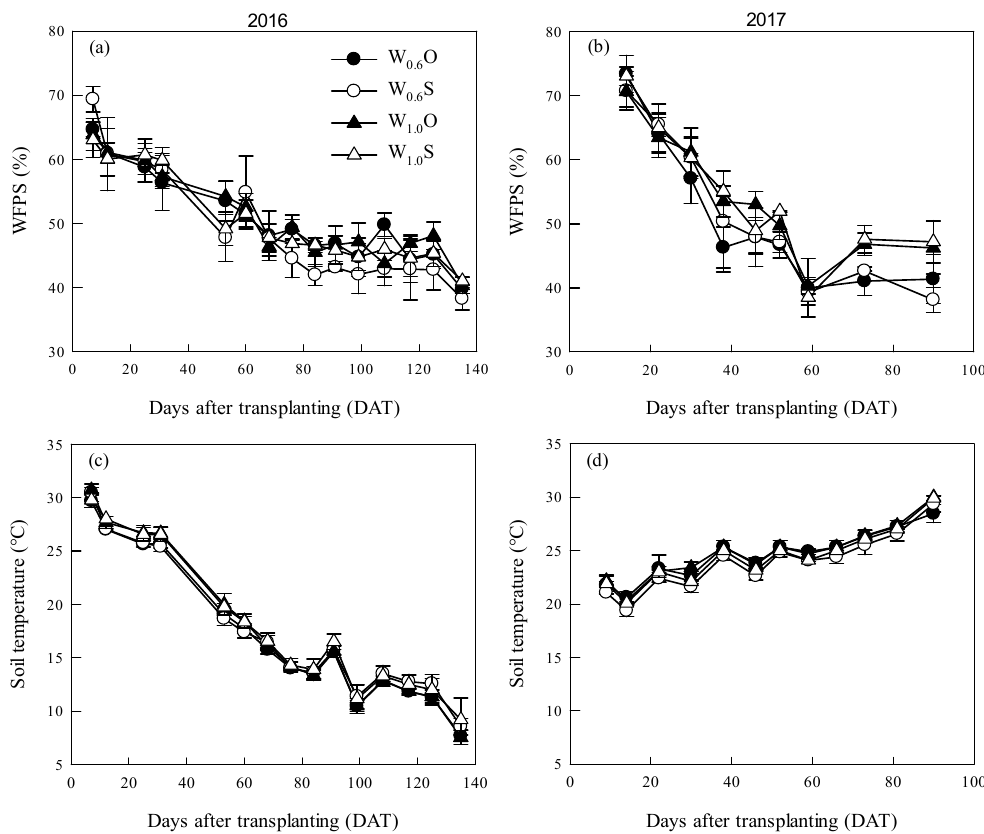
Figure 2. Variations of water-filled pore space (WFPS) ( a , b ) and soil temperature ( c , d ) among treatments. ( a , c ) and ( b , d ) represent soil parameters in the greenhouse tomato-growing seasons of 2016 and 2017, respectively.